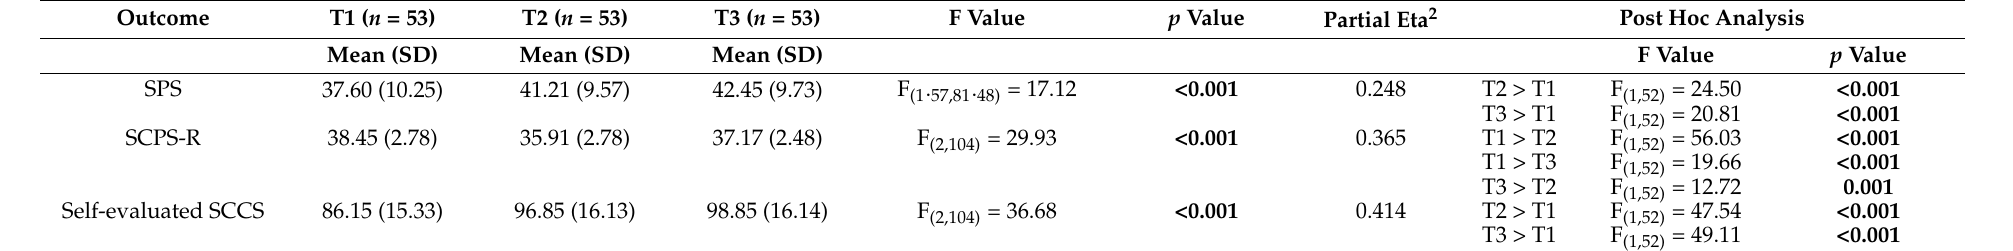
Table A3. Within-subject effects of experimental group on outcomes using RM